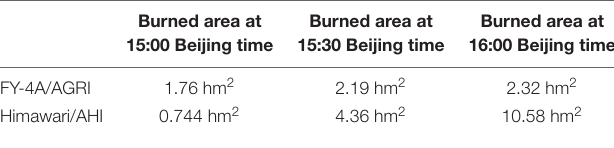
TABLE 3 | Comparison of burned area as estimated by FY-4A/AGRI and Himawari/AHI. Burned area at 15:00 Beijing